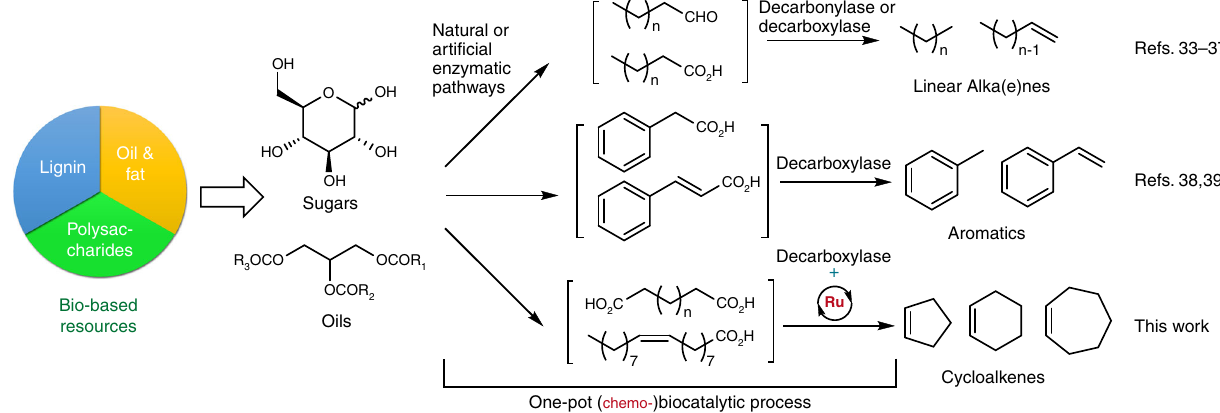
Fig. 1 Production of hydrocarbons from bio-based resources via (chemo-)enzymatic cascades. Bio-based linear alkanes and alkenes are produced from renewable feedstock via enzyme pathways that include decarbonylases or decarboxylases. Engineering a chemo-enzymatic cascade that comprises a decarboxylase and a ring-closing metathesis catalyst leads to the production of bio-based